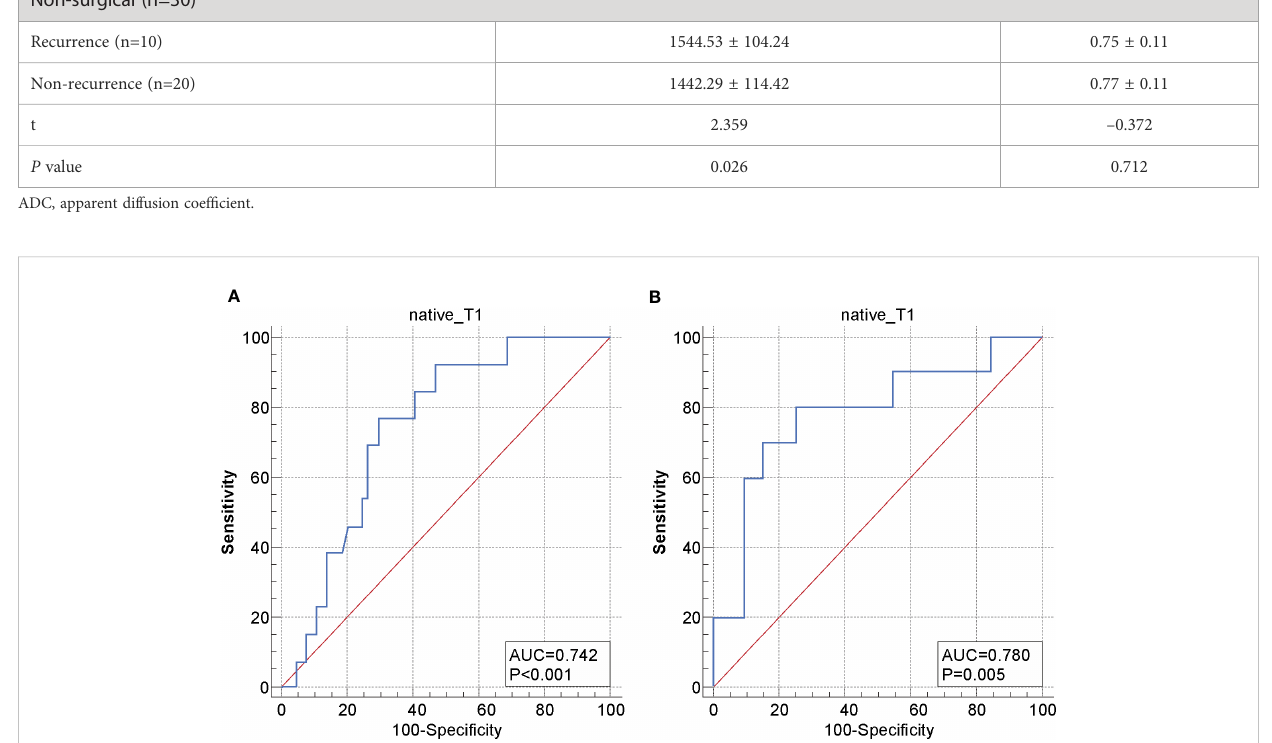
FIGURE 4 Receiver operating characteristic (ROC) curve of the native T1 values for distinguishing between the recurrence and non-recurrence subgroups in the (A) surgical and (B) non-surgical groups. TABLE 4 Results of logistic regression analysis of clinical variables and native T 1 value for the prediction of the recurrence of cervical cancer after treatment.